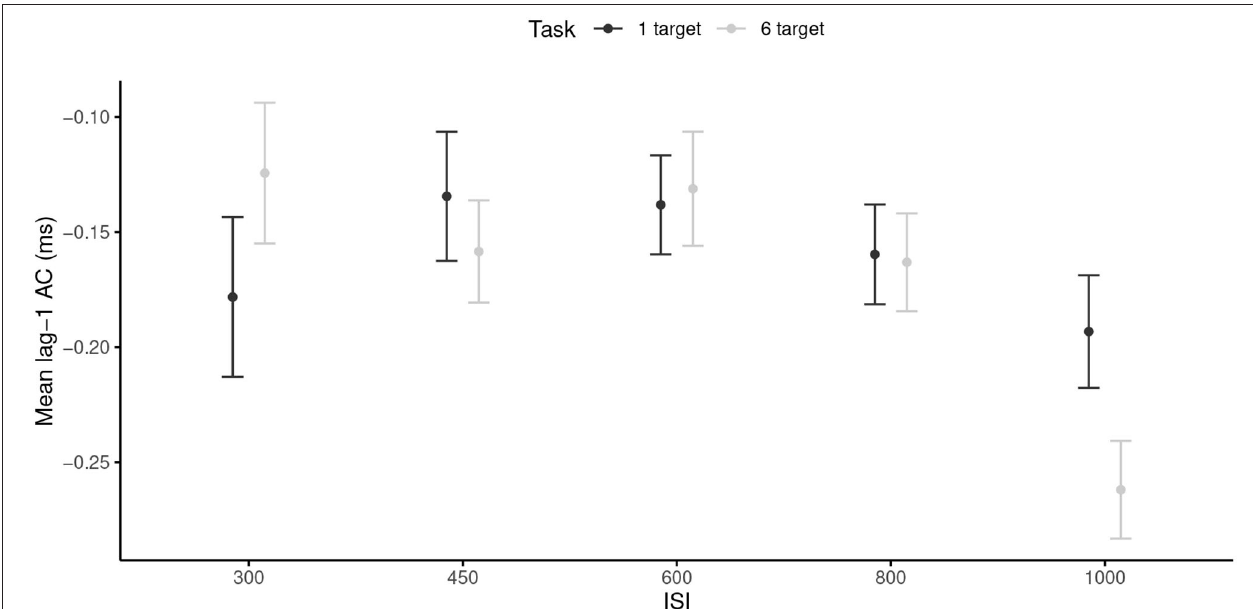
FIGURE 2 | Mean lag-1 ACs for each inter-stimuli interval, and each task. 95% are represented in the figure by the error bars attached to each mean point. AC, autocorrelation; ISI, inter-stimuli